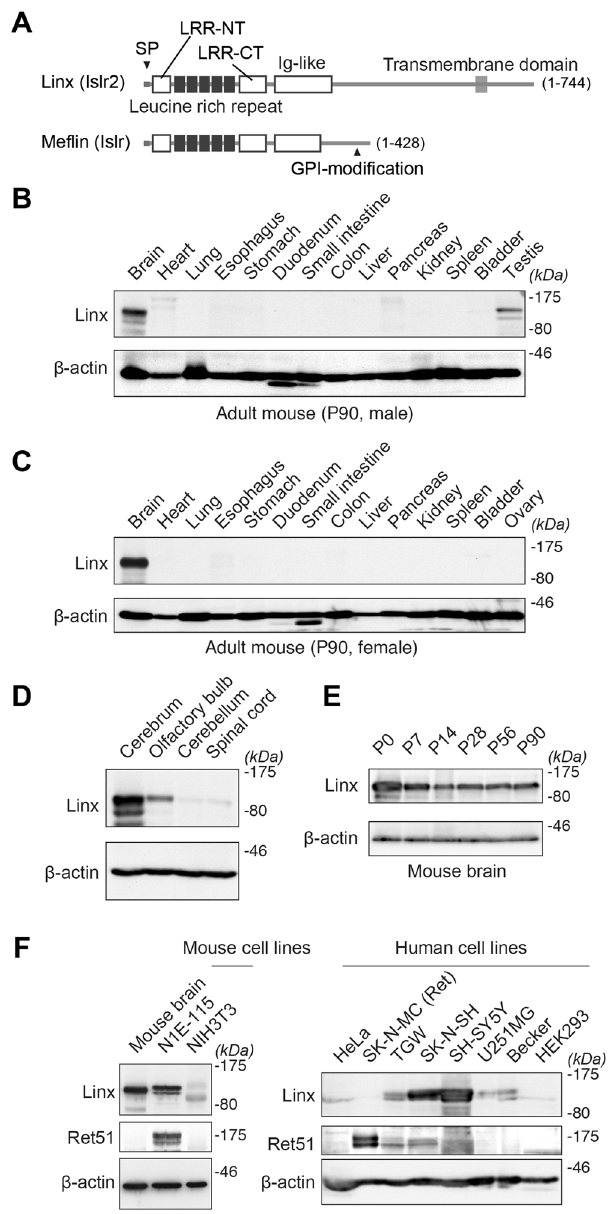
Figure 1. Linx expression in the forebrain and neuroblastoma cell lines. (A) Domain structures of Linx/ Islr2 and its paralogue Meflin/Islr. Amino acid numbers are shown in parentheses. SP, signal peptide; LRR, leucine-rich repeat; LRR-NT and CT, LRR N-terminal and C-terminal cysteine-rich domains; GPI, glycosylphosphatidylinositol. (B , C) Tissue distribution of Linx in adult male (B) and female (C) mice. Lysates prepared from the indicated tissues were analyzed by Western blot with the indicated antibodies. kDa , kilodaltons; P, postnatal day. Full blot images are shown in Supplementary Figure S3. (D) Linx is preferentially expressed in the forebrain but not the hindbrain nor the spinal cord. Full blot images are shown in Supplementary Figure S3. (E) Linx is expressed in the brain throughout postnatal and adult stages in mice. Full blot images are shown in Supplementary Figure S3. (F) Linx expression in mouse and human cell lines. Lysates prepared from each mouse (left) and human (right) cell line were subjected to Western blot analysis, which revealed high levels of Linx expression in the neuroblastoma cell lines including N1E-115, SK-N-SH, and SH- SY5Y. Full blot images are shown in Supplementary Figure